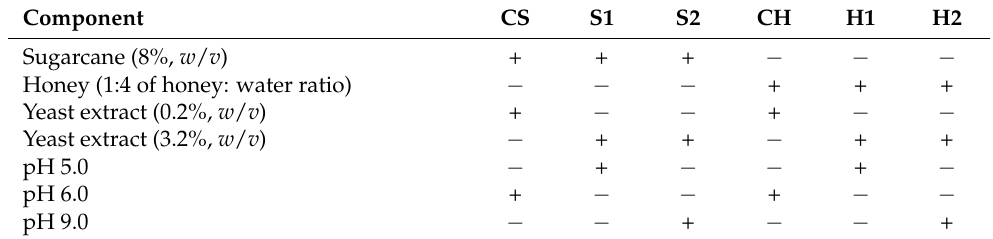
Table 1. The composition of new formulas of sugarcane (S1 and S2) and honey (H1 and H2) solutions. Component